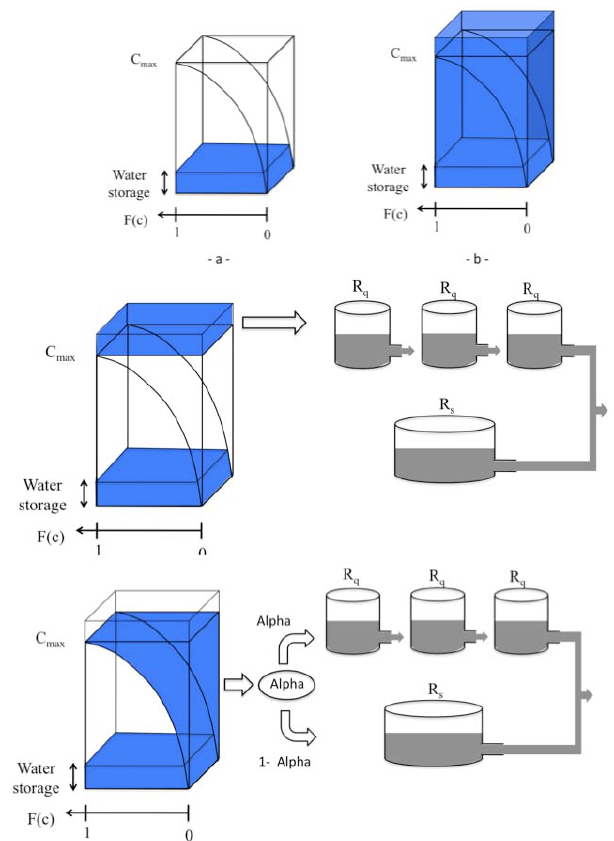
Fig. 1. Runoff generation in JGrass-NewAge System. (Top) On the left a representation of partially filled reservoirs; on the right the case of precipitation exceeding the storage capacity. (Center) When the total storage is exceeded, the precipitation excess is directly routed as overland flow by using three linear reservoirs. (Bottom) For precipitation not exceeding C max the volume of precipitation above the curve is divided into overland flow and subsurface flow according to a coefficient of partition